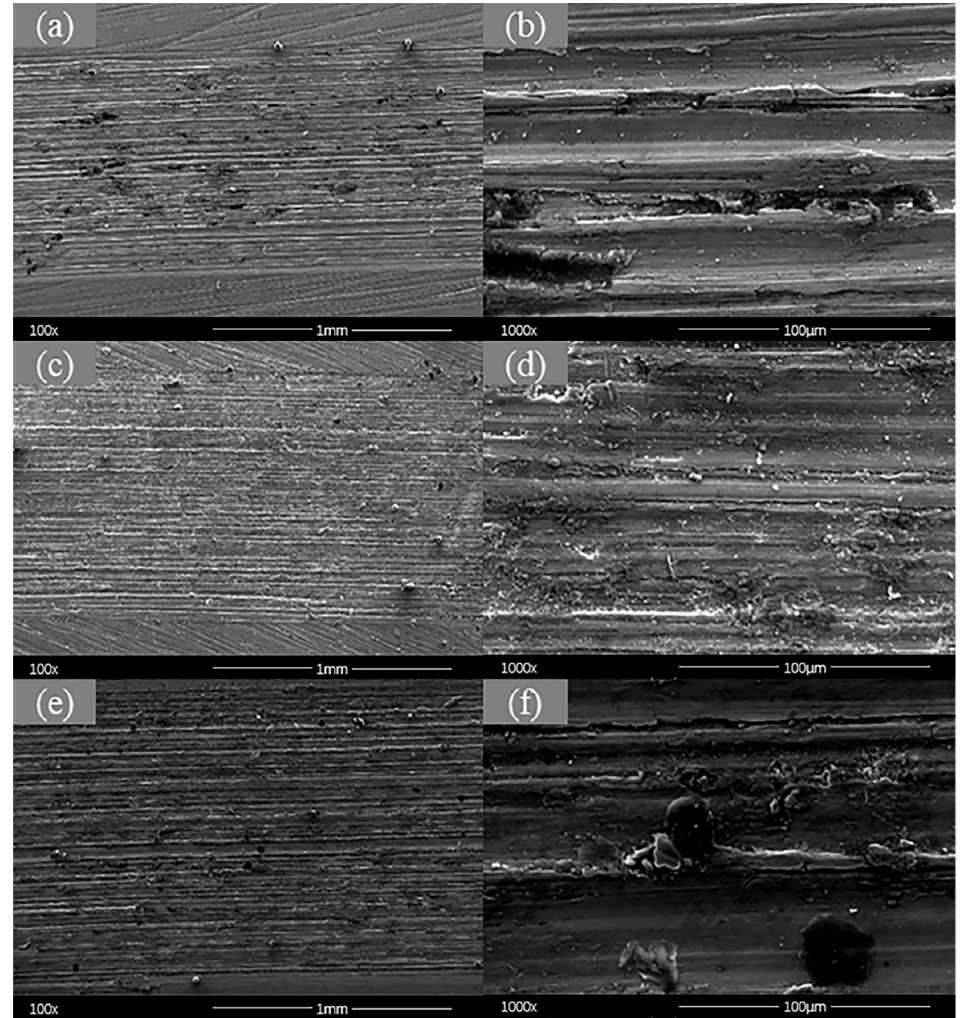
Figure 8. Wear morphology of Ti-6Al-4V alloy under different load. ( a , b ): 3 N; ( c , d ): 6 N; ( e , f ): 9 N.